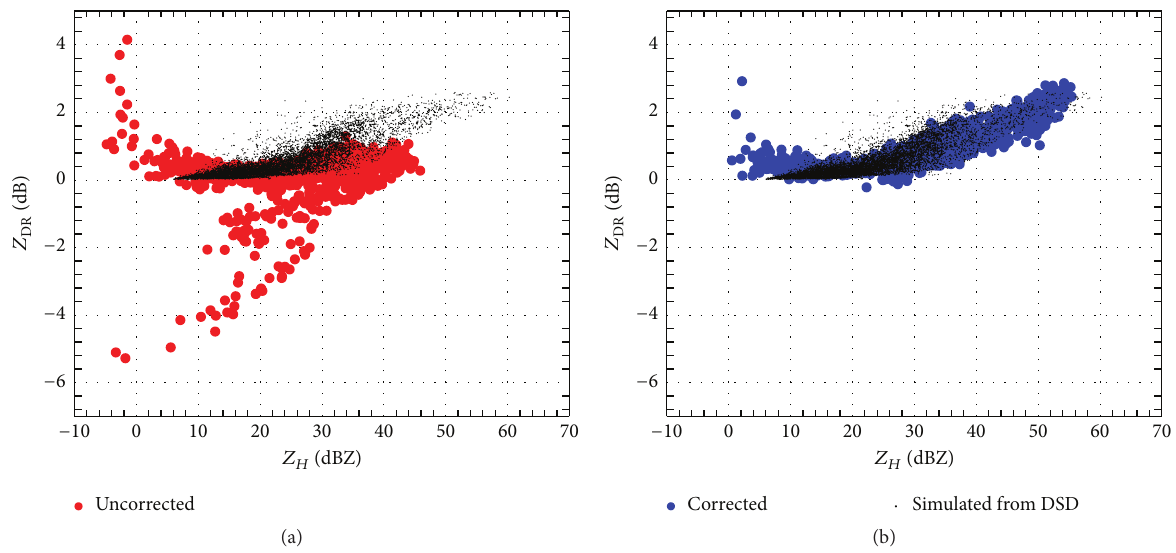
Figure 13: Scatter plots of 𝑍 𝐻 and 𝑍 [21]).